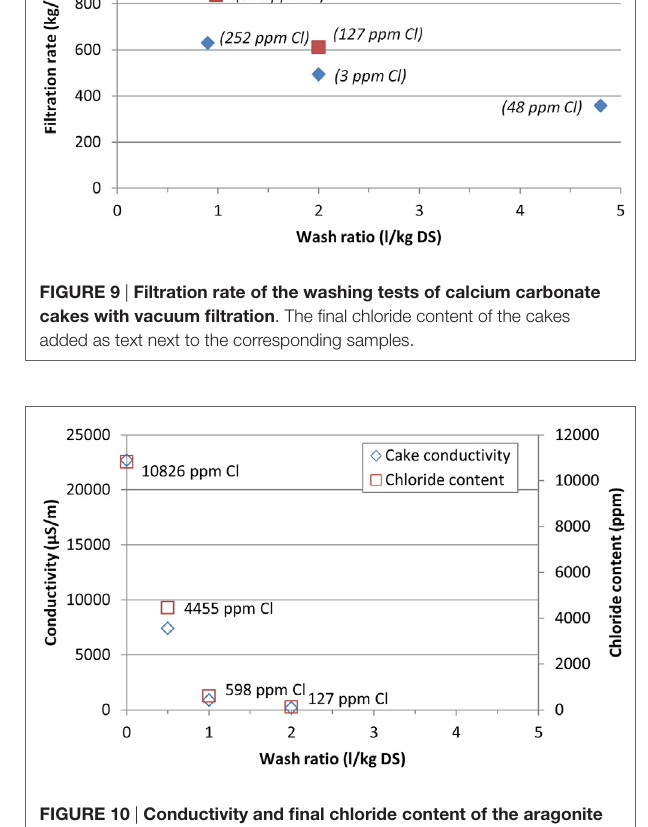
FigUre 10 | conductivity and final chloride content of the aragonite cake with vacuum filtration using different wash ratios .